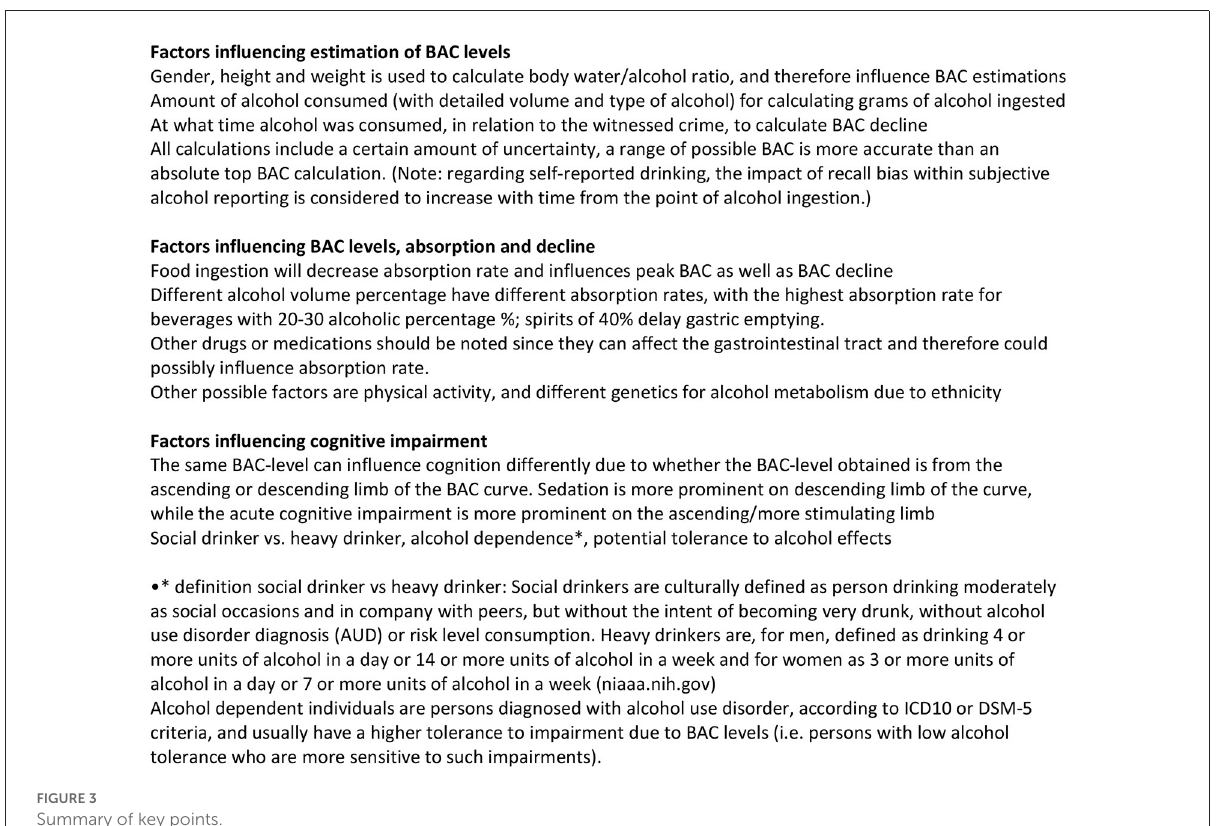
FIGURE3 Summary of key